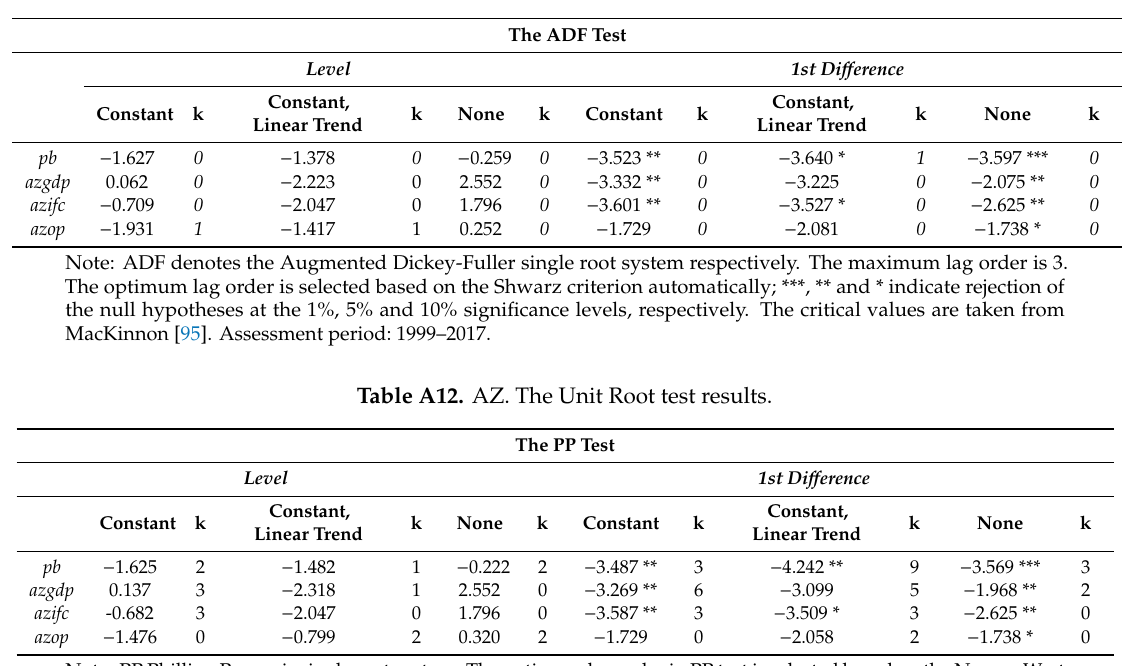
Table A11. AZ. The Unit Root test results.